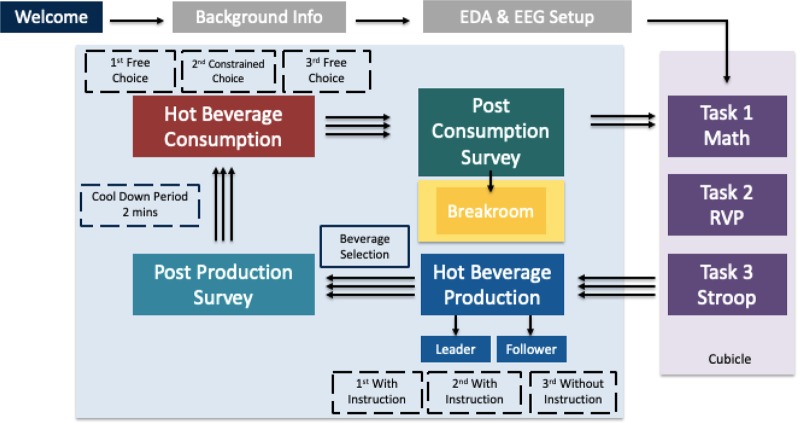
Research procedure.